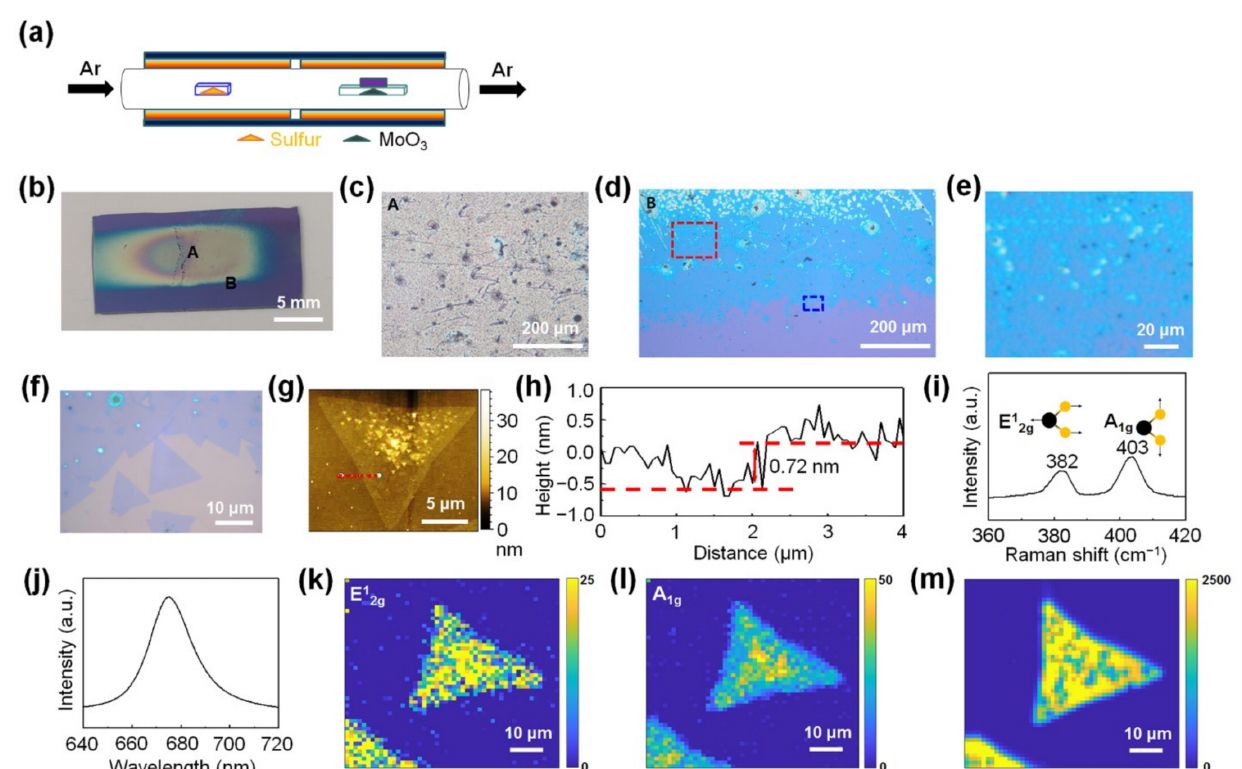
Figure 1. Conventional chemical vapor deposition (CVD) growth of MoS 2 . ( a ) Schematic illustration of the experimental setup for the conventional CVD growth of MoS 2 . ( b ) Optical image of the MoS 2 synthesized on an SiO 2 /Si substrate using the conventional CVD method. ( c ) Magnified optical image of the region A in ( b ). ( d ) Magnified optical image of the region B in ( b ). ( e ) Magnified optical image of the dotted red rectangle in ( d ). ( f ) Magnified image of the dotted blue rectangle in ( d ). ( g ) Atomic force microscopy (AFM) height image of monolayer MoS 2 synthesized using the conventional CVD method. ( h ) Height line profiles along the dotted red line in ( g ). ( i ) Raman and ( j ) photoluminescence (PL) spectra of monolayer MoS 2 . ( k , l ) Raman maps of the E 2g mode and A 1g mode of MoS 2 , respectively. ( m ) PL map of monolayer MoS 2